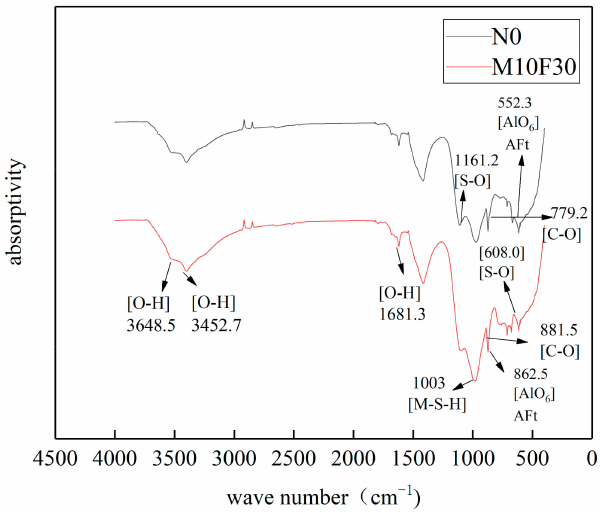
Figure 16. Infrared spectrum of M10F30 concrete in magnesium sulfate